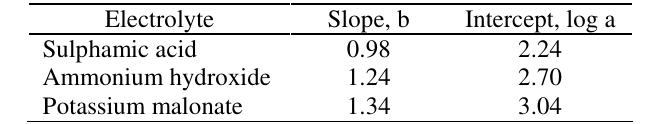
Table 1. Parameters in equation (1) for